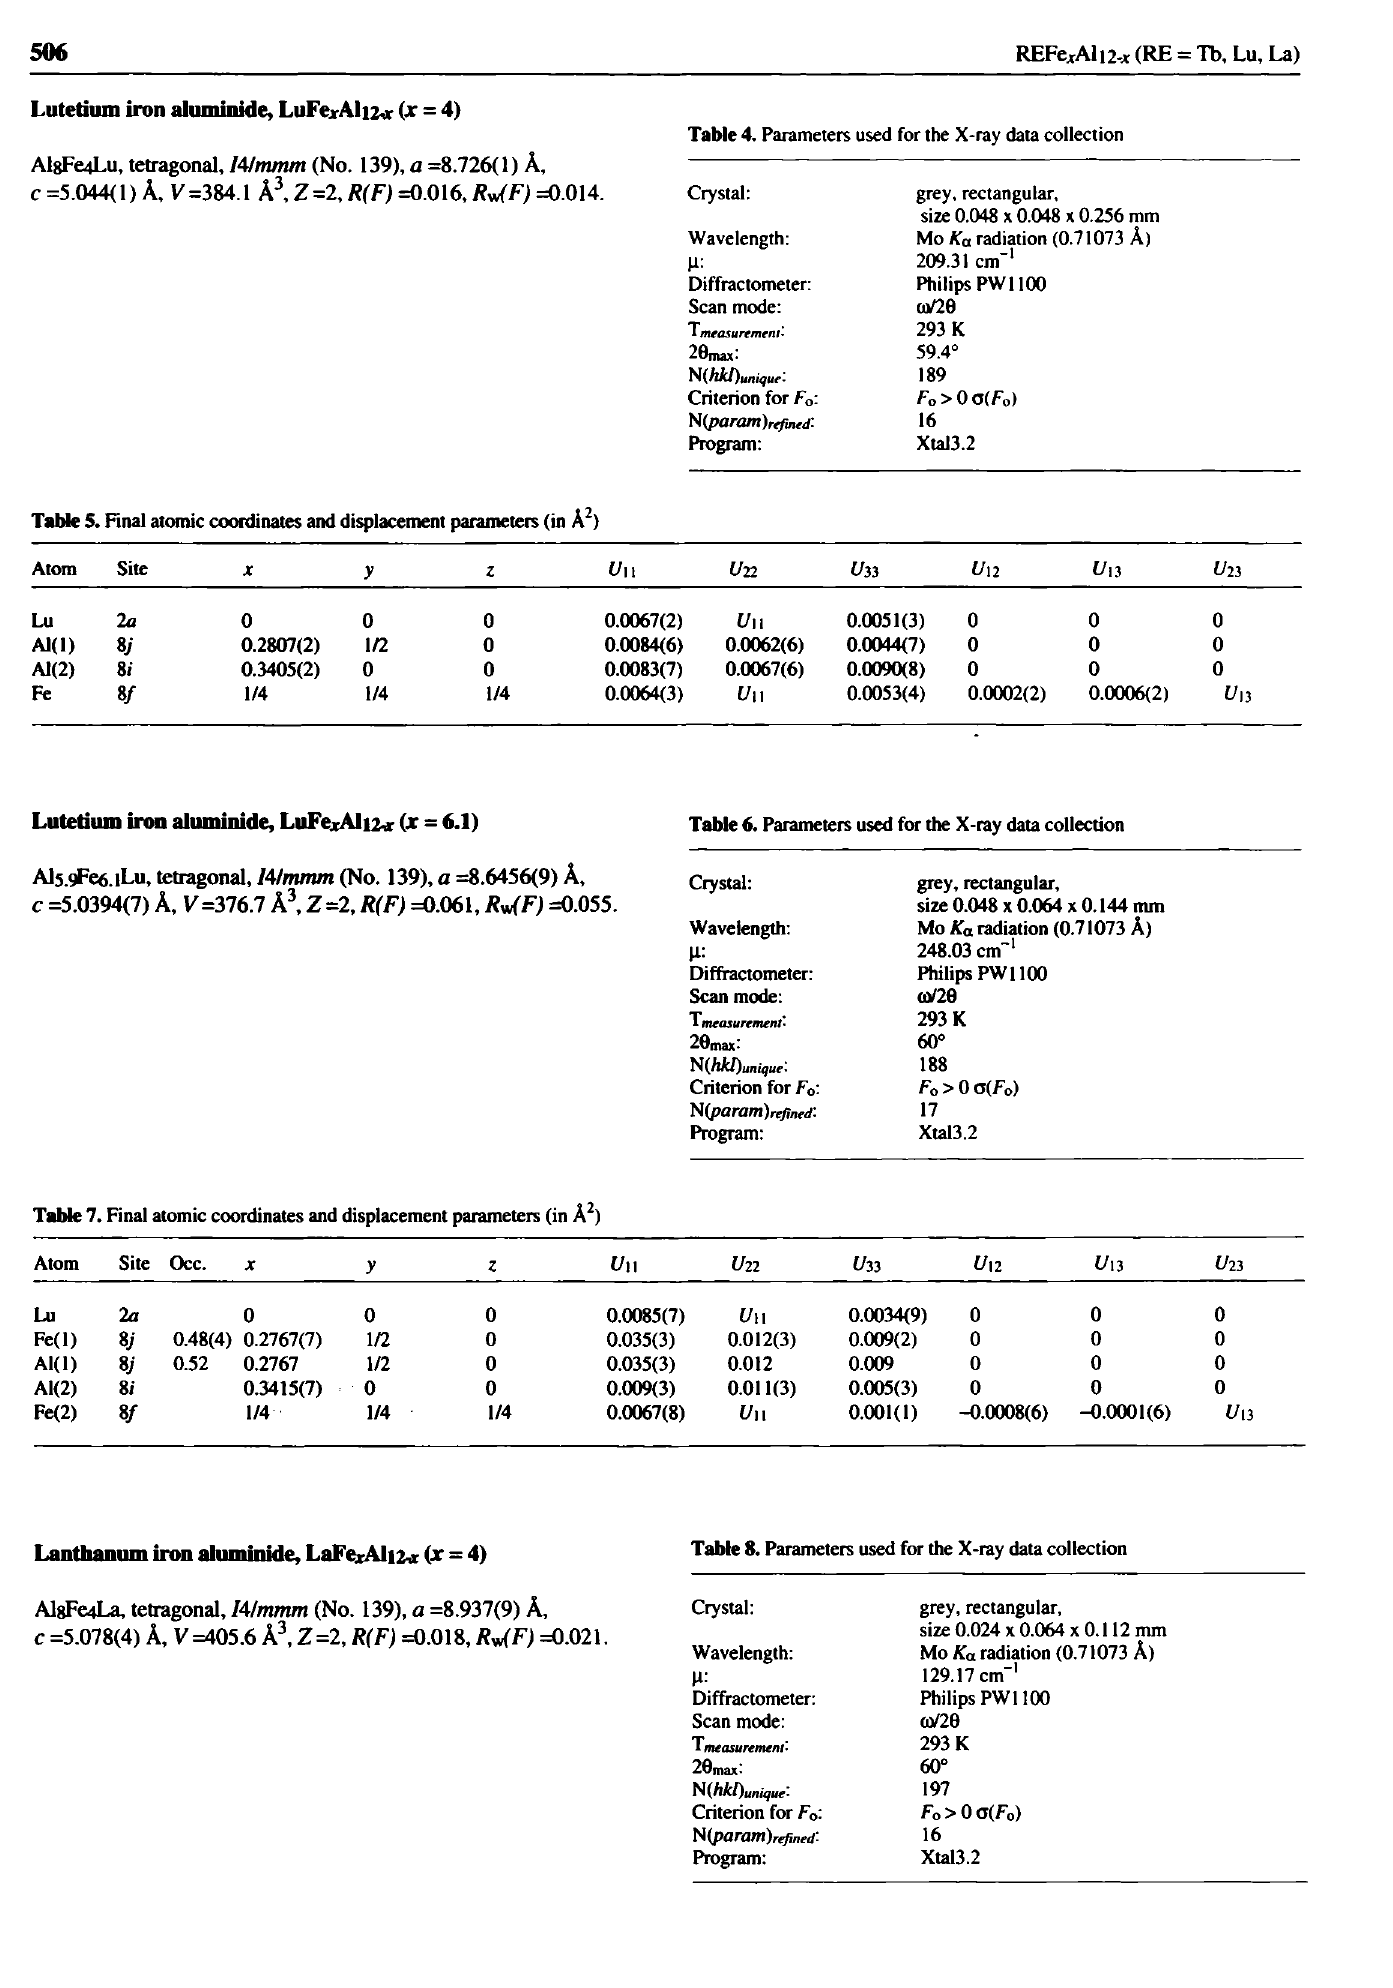
Table 8. Parameters used for the X-ray data